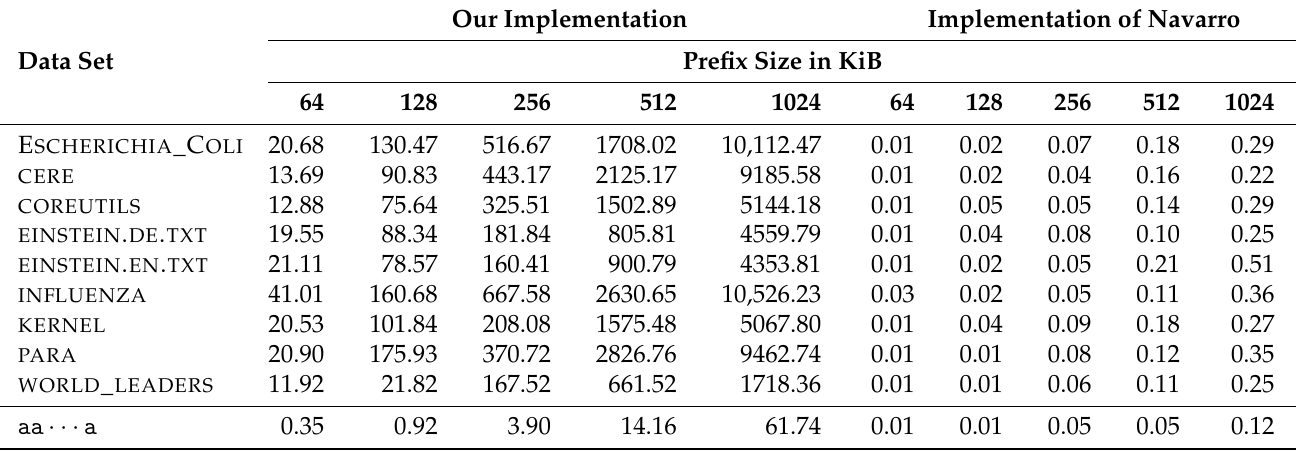
Table 1. Experimental evaluation of our implementation and the implementation of Navarro described in Section 2.6. Table entries are running times in seconds. The last line is the benchmark on the unary string aa · · · a .